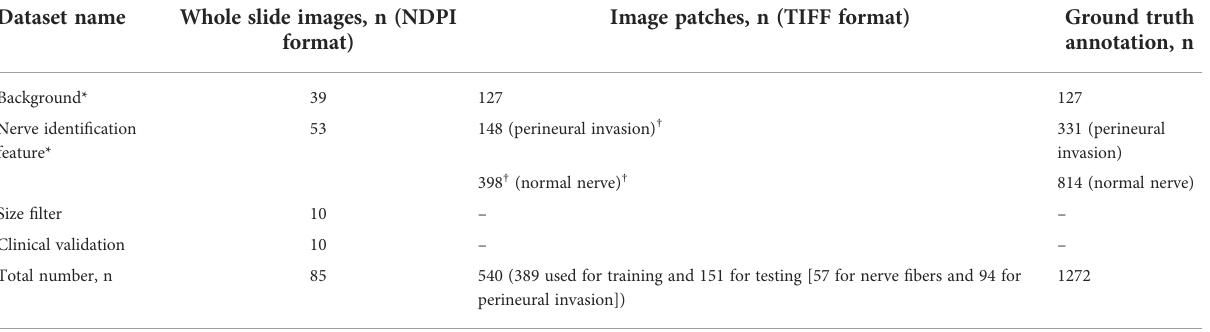
TABLE 2 Summary of image acquisition and data